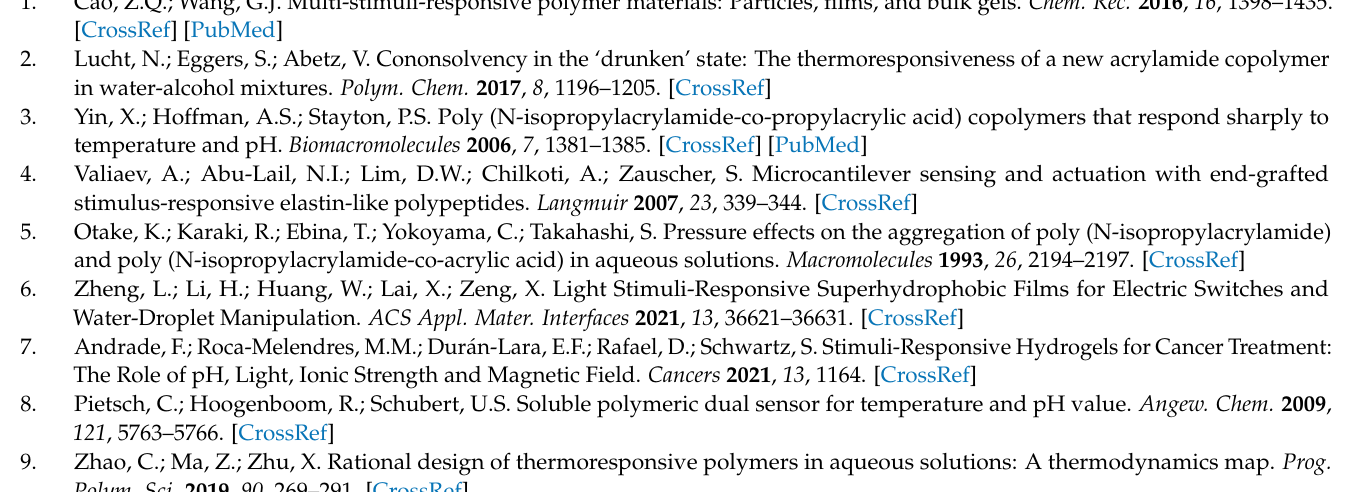
Supplementary Materials: The following are available online at https://www.mdpi.com/article/ 10.3390/polym14010062/s1, Figure S1: 1 H NMR spectra recorded in (a) CDCl 3 for a P(DMA 29 - Table S1: Extended Kelen-Tüd˝os parameters for the RAFT copolymerization of DMA and NIPAM in 1,4-Dioxane at 70 ◦ C; Figure S2: Determination of r DMA and r NIPAM by the extended Kelen- Tüd˝os method; Figure S3: TEM image and evaluation of the particle size distributions of P(DMA 35 - NIPAM 212 )-PS 1089141 . (a) Exemplary TEM micrograph of a diluted P(DMA 35 -NIPAM 212 )-PS 1089141 dispersion in water and at room temperature (preparation method 1). (b) Size distribution of latex particles taken from analysis of TEM micrographs of the sample exemplary shown in (a). Figure S4 TEM images and evaluation of the particle size distributions of P(DMA 35 -NIPAM 212 )-PS 1089141 dispersions diluted with 0.5 M salt solutions. (a) Exemplary TEM micrographs of a P(DMA 35 - NIPAM 212 )-PS 1089141 dispersion diluted with an aqueous 0.5 M NaBr solution, freeze-dried and at room temperature (preparation method 2). (b) Size distribution of latex particles taken from analysis of TEM micrographs of the sample exemplary shown in (a). (c) Exemplary TEM micrograph of a P(DMA 35 -NIPAM 212 )-PS 1089141 dispersion diluted with an aqueous 0.5 M NaSCN solution and freeze-dried at room temperature (preparation method 2). (d) Size distribution of latex particles taken from analysis of TEM micrographs of the sample exemplary shown in